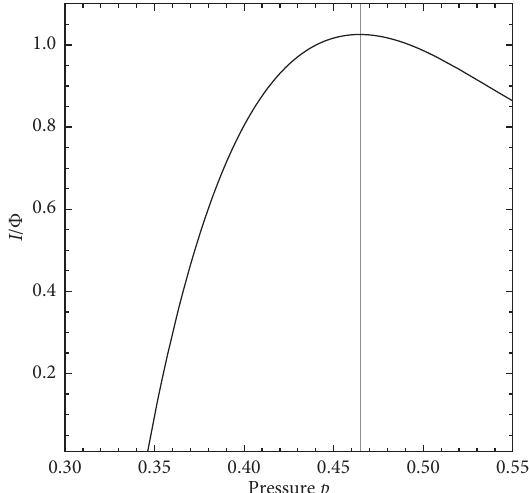
Figure 5: The ratio I / Φ against p calculated with the Pad´e approximant of (10). The vertical line marks the maximum of I / Φ on p ∈ [ 0 ,p c ]